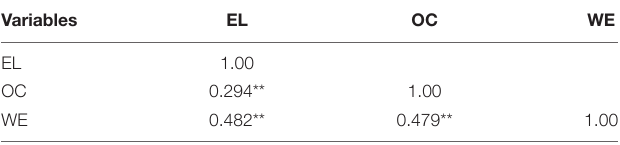
TABLE 2 | Correlations between